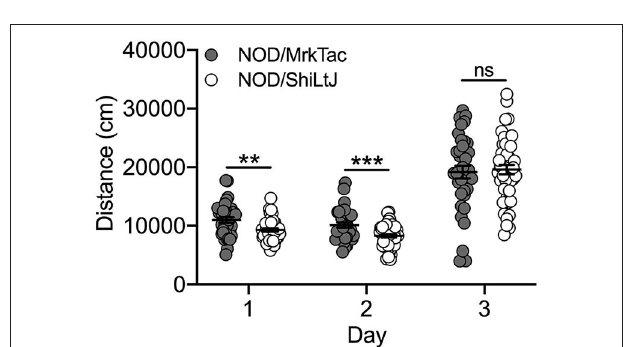
= 3.5; p = 7.7 x 10–4) but not following cocaine exposure on Day 3 ( Figure 6 ). No significant sex differences were detected.